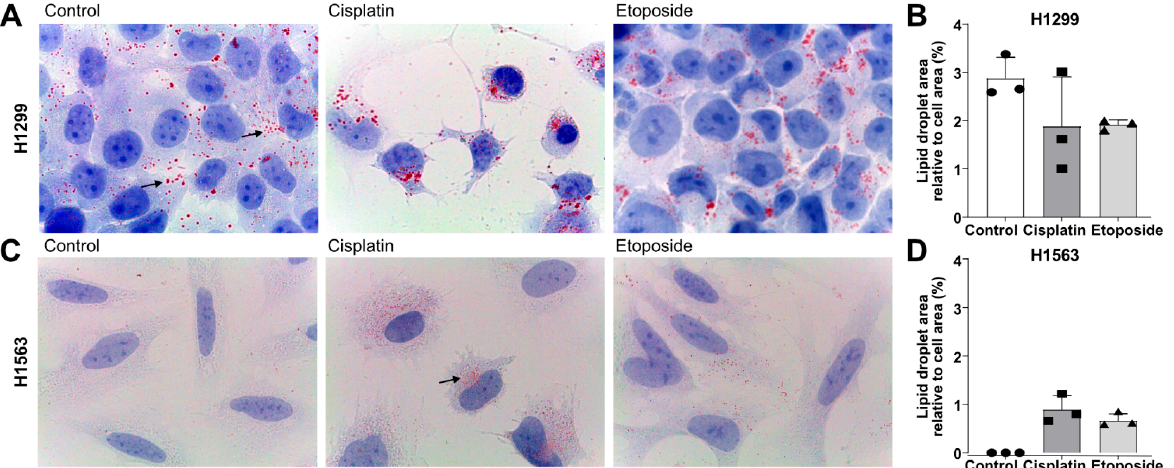
Figure 6. Influence of cisplatin and etoposide treatments on lipid droplet (LD) formation. LDs in H1299 ( A ) and H1563 ( C ) were stained with Oil red O after 48 h incubation in BM (basal medium)